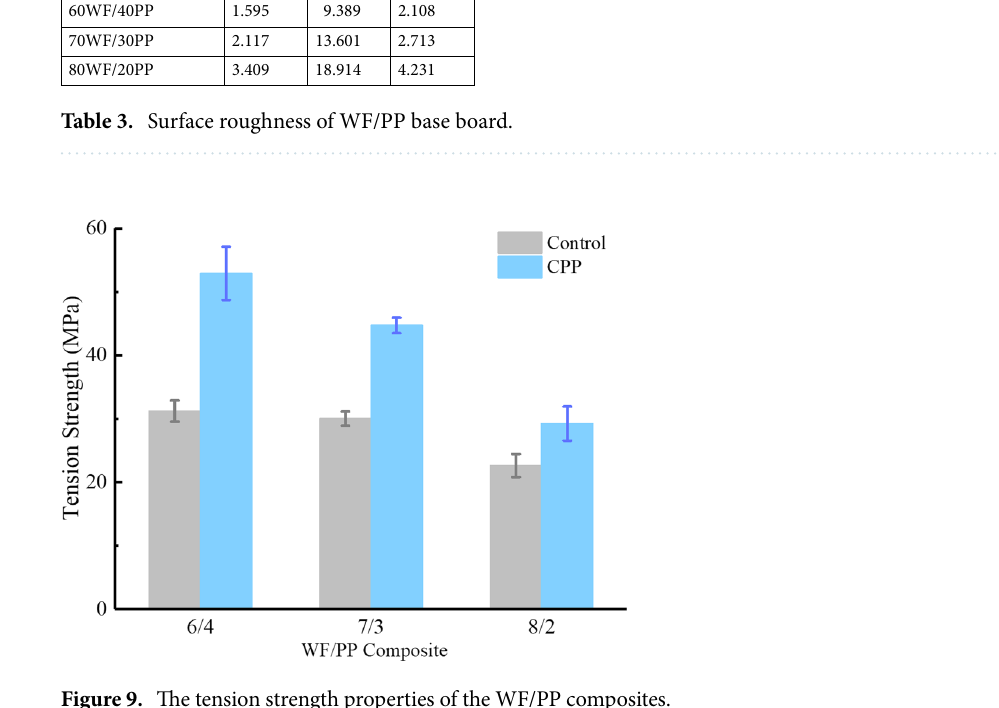
Figure 9. The tension strength properties of the WF/PP